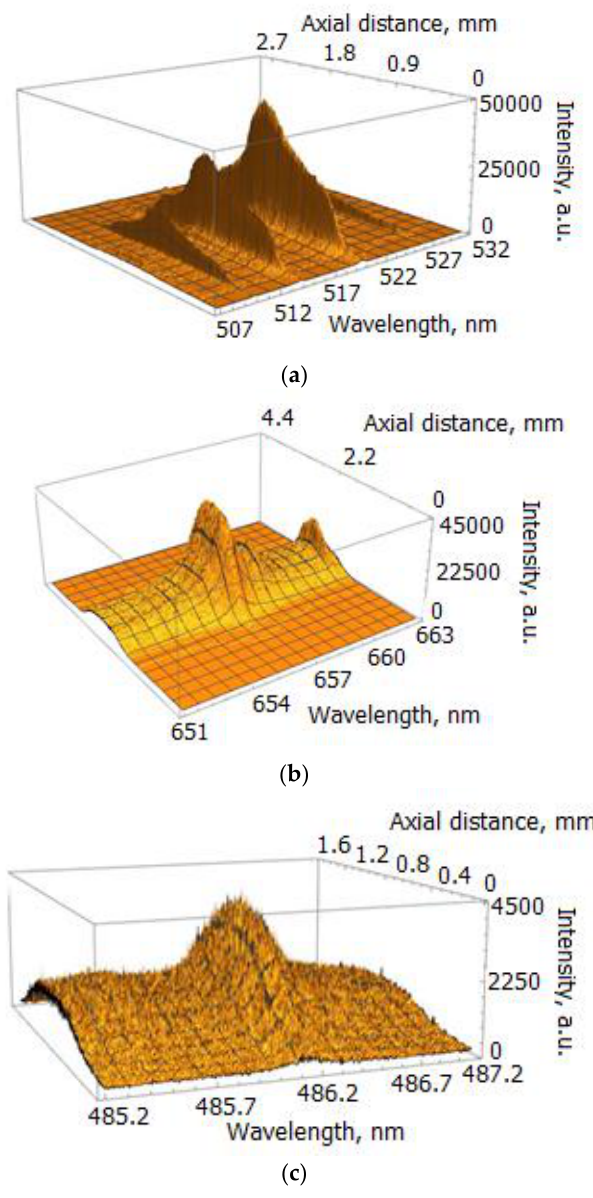
Figure 3. Spatially resolved spectrum images of the selected lines; exposure time of the EMCCD τ = 200 μs: ( a ) spectrum of Cu I lines registered for I = 400 A; ( b ) H α line registered for I = 400 A; ( c ) H β line registered for I = 660 A.